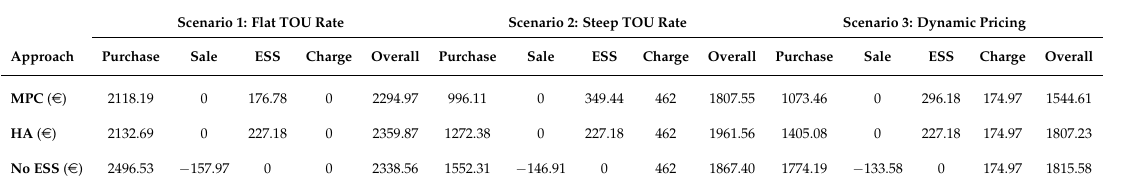
Table 2. Economic costs in a simulation of one week in the three considered scenarios *. Scenario1: FlatTOURate Scenario2: SteepTOURate Scenario3: